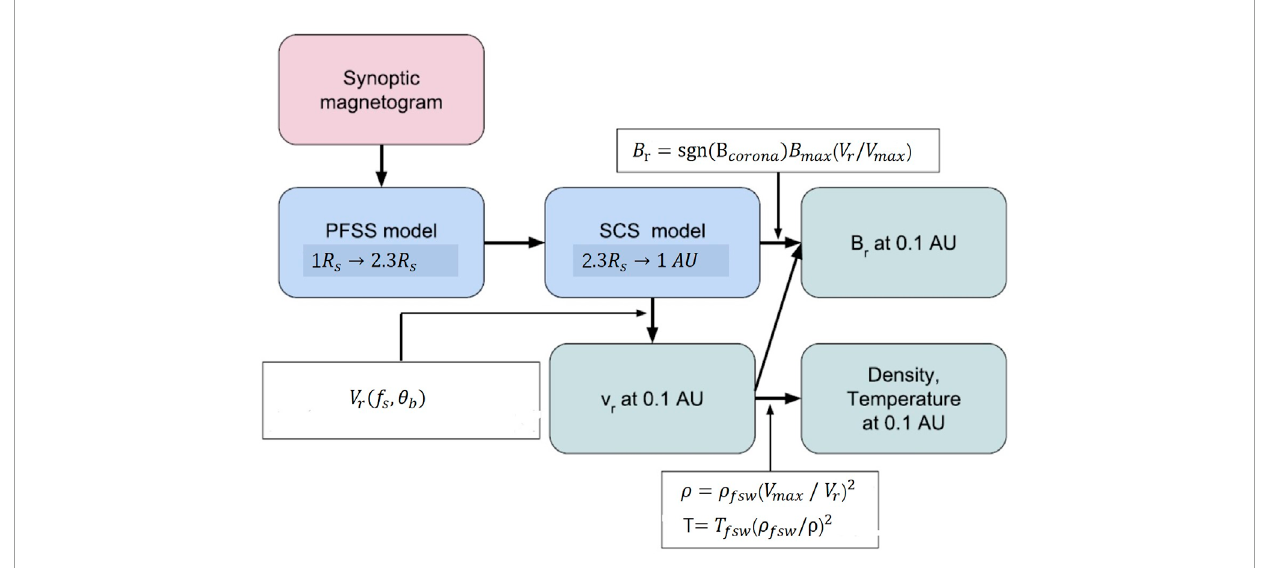
FIGURE 4 Sequence of steps that provide the boundary conditions for the heliospheric MHD model (Pomoell and Poedts, 2018).